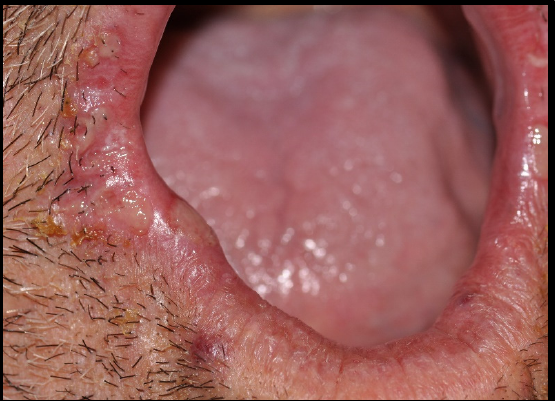
Figure 6. Herpes simplex virus infection on both lip commissures, presenting with blisters and crusting. The patient, on nivolumab, was in pain for more than one month.